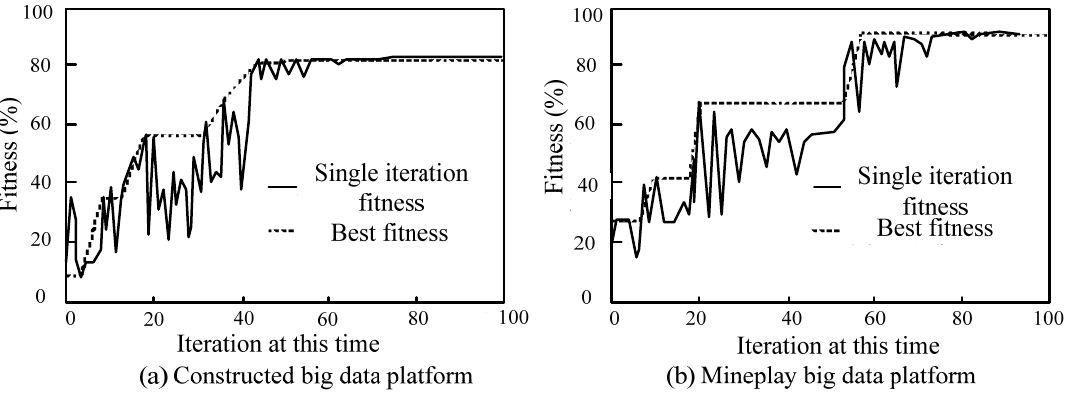
Figure 6. Data sensitivity analysis of big data platform.